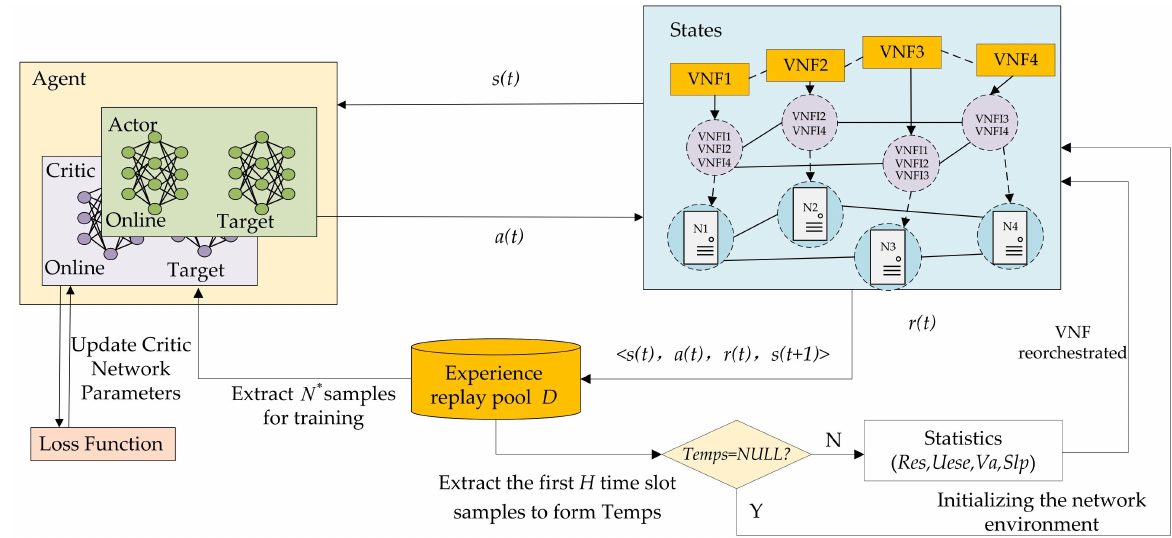
Figure 2. The ISM-DRL